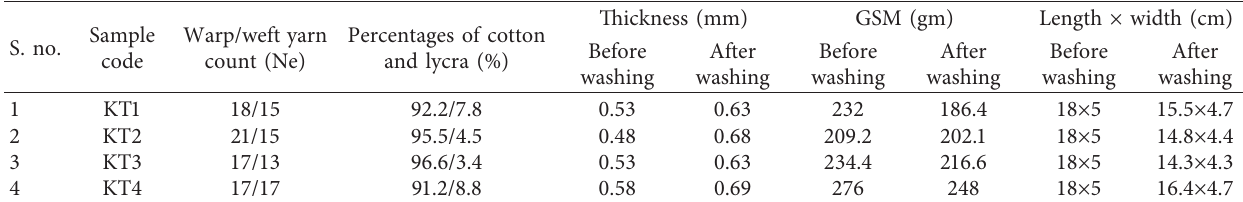
Figure 5: (a) Tensile testing machine with the heating chamber and (b) sample mounting Table 2: Physical properties of tapes before and after washing the adhesive.